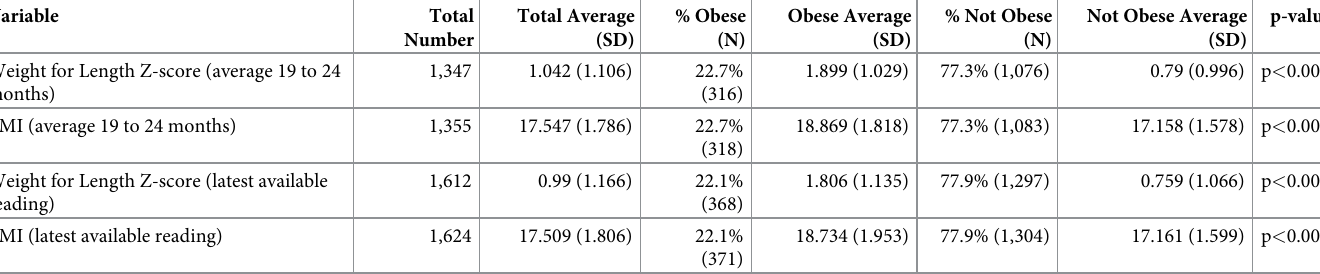
Table 4. Individual feature associations for girls with obesity between ages 4.5 and 5.5. Variable